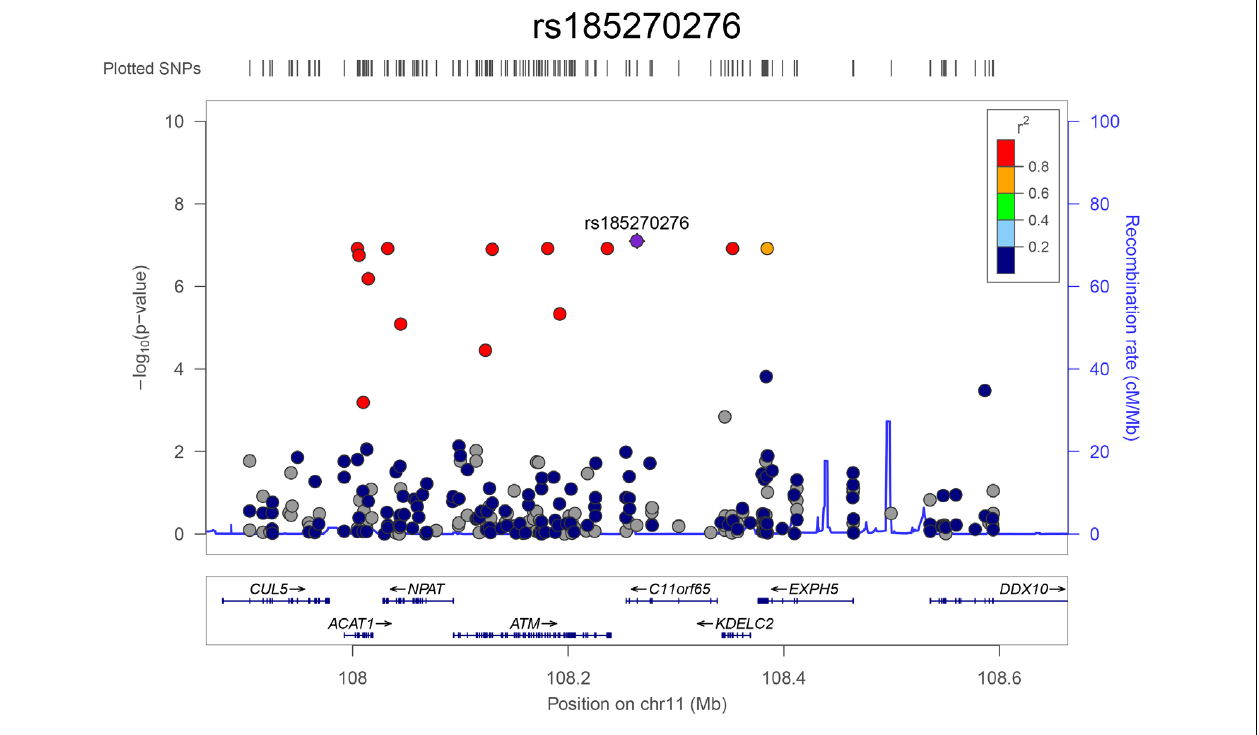
available in Table 4 and in Supplementary Table 1 , which also contains cohort specific information. The Manhattan and QQ- plots are provided in Supplementary Figures 3, 4 ,